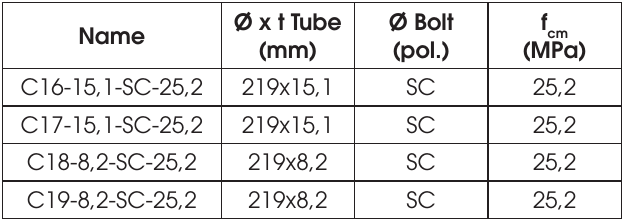
Names and characteristic of experimental